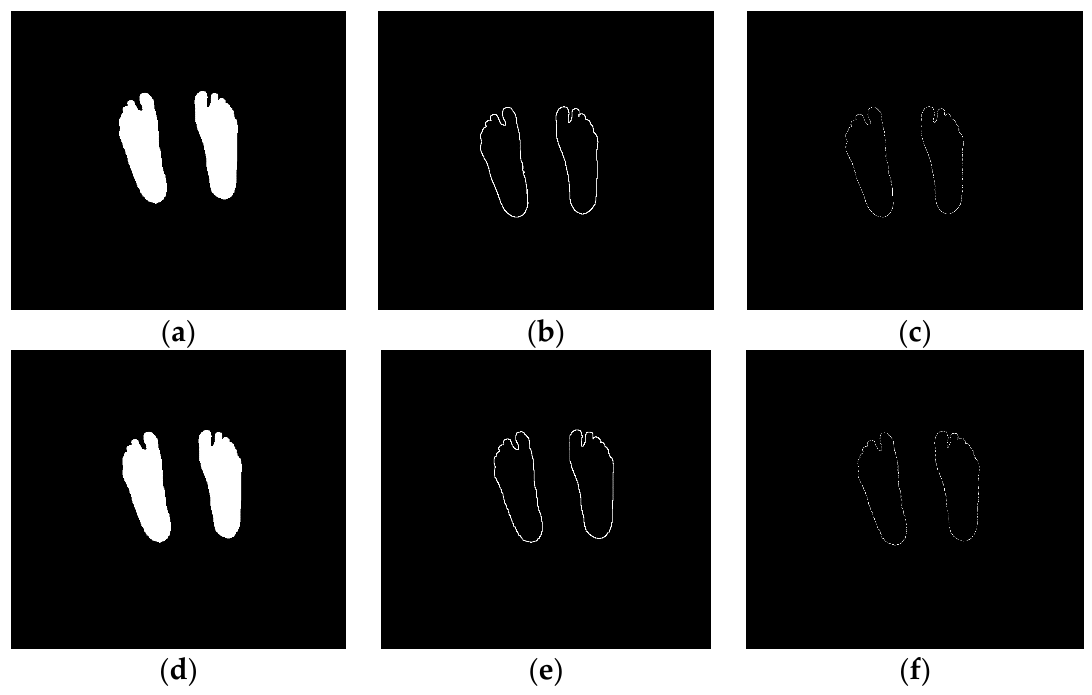
Figure 4. ICP image processing pipeline to extract the set of keypoints. Left: input images used for this application, ( a ) visible STAPLE mask image and ( d ) thermal STAPLE mask image. Center: edge detection filtering result that extracts the feet contours, ( b ) visible edge detection and ( e ) thermal edge detection. Right: keypoints selection used for the ICP registration process, ( c ) visible mask keypoints used for ICP and ( f ) thermal mask keypoints used for ICP.